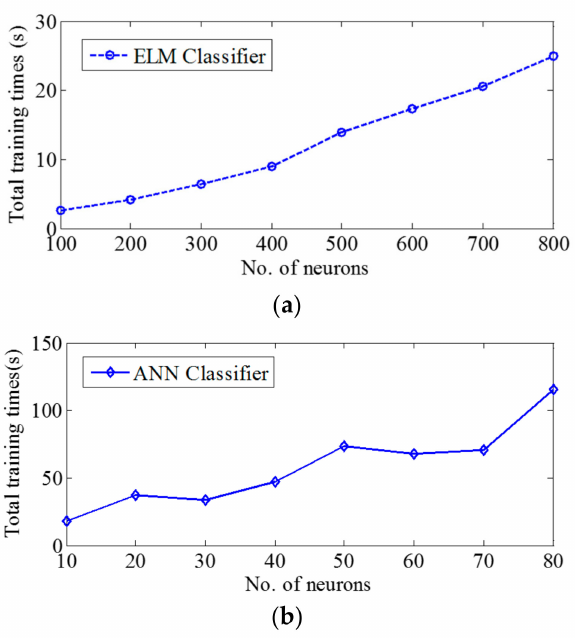
Figure 7. Total training times obtained from both classifiers: ( a ) ELM; ( b )